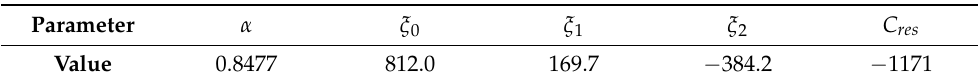
Table 6. Parameter identification results of 5-axis variable-angle laser engraving depth model (all parameters are dimensionless).